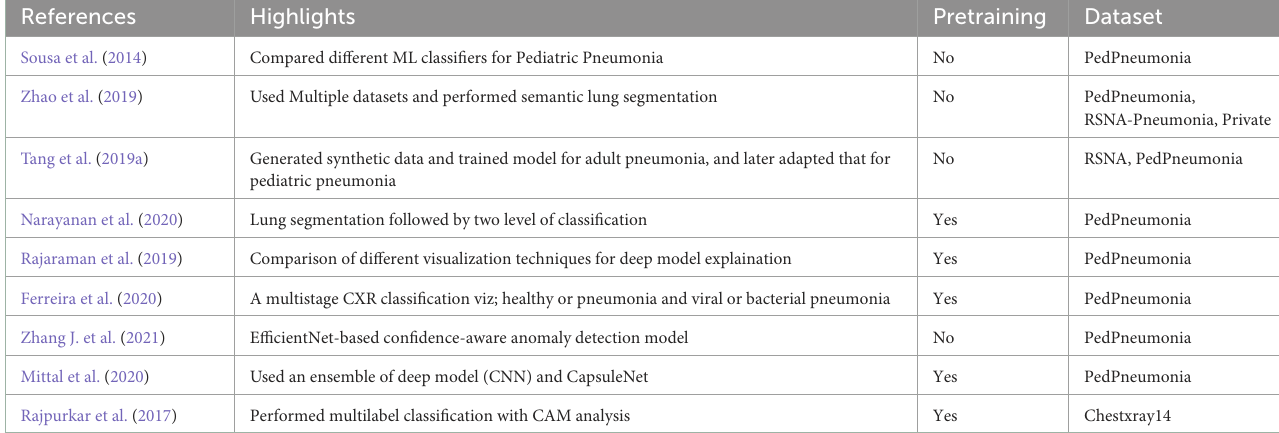
TABLE 5 Summarizes the literature for Pneumonia detection using